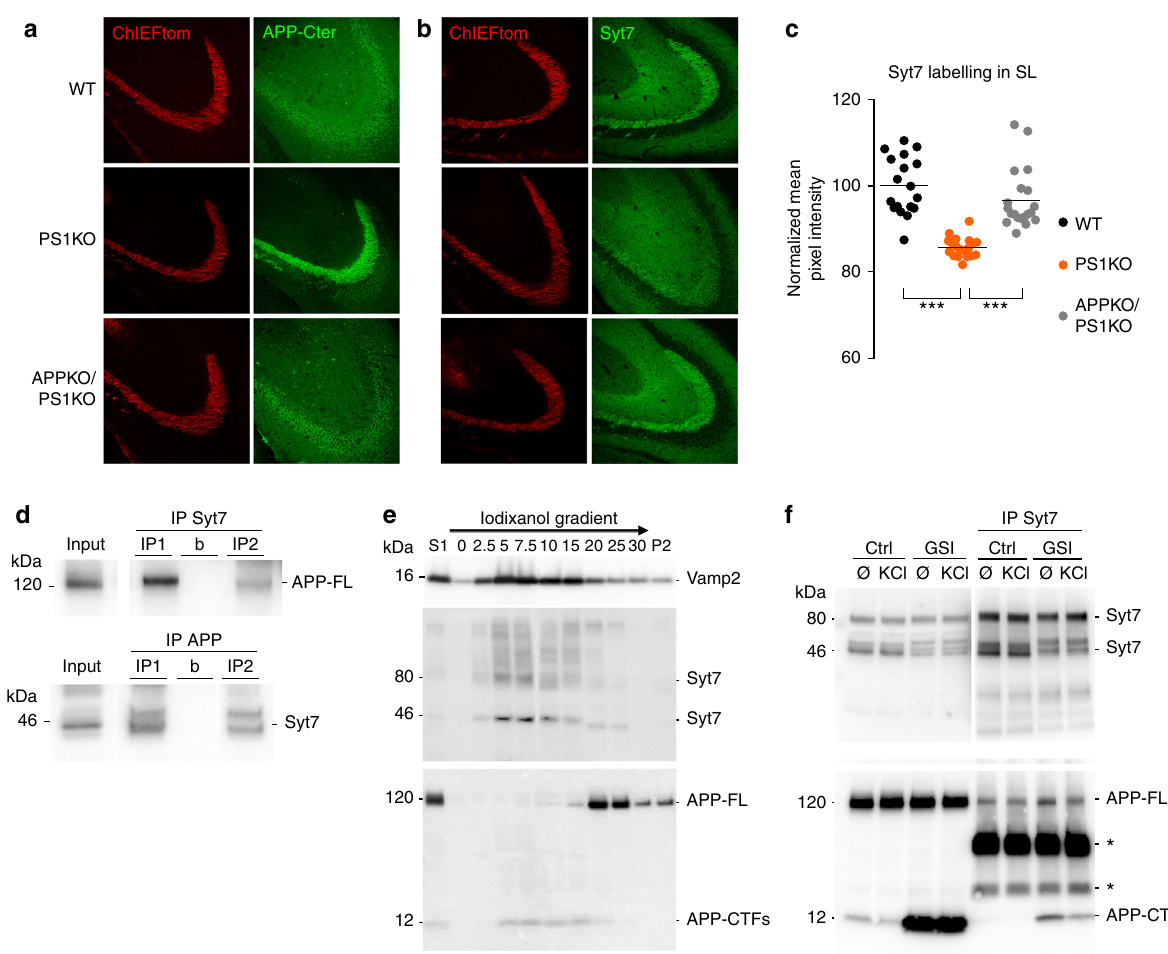
Fig. 7 PS regulation of Syt7 expression depends on APP-CTFs, new interacting partners of Syt7. a Confocal images of ChIEFtom (red channel) and APP- Cterminal (detected with C1/6.1 antibody, green channel) in the Mf tracts in WT, PS1KO, and PS1KO/APPKO conditions. Mfs are faintly labelled with the APP antibody in WT and barely in APPKO/PS1KO. In contrast, PS1KO Mfs display strong labelling of APP. b Confocal images as in a displaying Syt7 labelling. Mfs are strongly labelled in WT and in APPKO/PS1KO but faintly in PS1KO. c Scatter plots of the mean pixel intensity in the SL normalized to the mean pixel intensity in the stratum radiatum report a reduction of 18%. In this condition, 50% of the GCs are infected by a Cre-expressing LV thus ∼ 50% of the Mfs are projected from non-infected (PS expressing) GCs. d WB from synaptosomal samples prepared from whole brains of adult mice. Top: IP of Syt7 pulled-down APP-FL. Bottom: IP of APP pulled-down Syt7. The characterization of the synaptosomal fraction is depicted in Supplementary Fig. 7. b: beads + immuno-precipitating antibody without sample. e Western-blot of cellular fractions from cultured neurons separated on an iodixanol gradient. VAMP2, Syt7, and APP-CTFs are enriched in light fractions while APP-FL is present in heavier fractions. f Samples prepared from cultured neurons treated or not with GSI from 10 to 14 DIV and with or without KCl (30 mM) for 15 min before lysis. In the inputs, detection of APP Cterminal with the Y188 antibody indicates that GSI induces CTFs accumulation. IP of Syt7 pulled-down APP-FL and CTFs. Asterisks indicate light and heavy chains of the immuno- precipitating antibody. Syt7/CTFs interaction is decreased by KCl treatment suggesting that it is regulated by neuronal